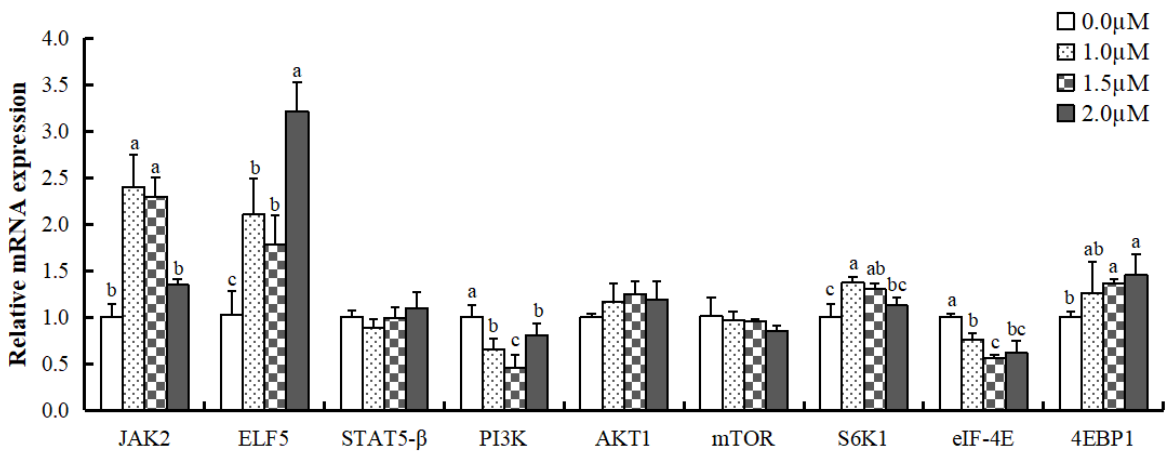
Figure 2. mRNA expression levels of casein synthesis-related genes in differentiated MAC-T cells treated with all-trans retinoic acid. JAK2, janus kinase 2; ELF5, E74-like factor 5; STAT5- β , signal transducer and activator of transcription 5 β ; PI3K, phosphoinositide 3-kinase; AKT1, RAC-alpha serine/threonine-protein kinase; mTOR, mammalian target of rapamycin; S6K1, S6 kinase beta-1; eIF4E, eukaryotic initiation factor 4E; 4EBP1, 4E binding protein 1. Data are mean±standard deviation (n = 3). a-c mRNA levels of the same gene with different superscript letters are significantly different